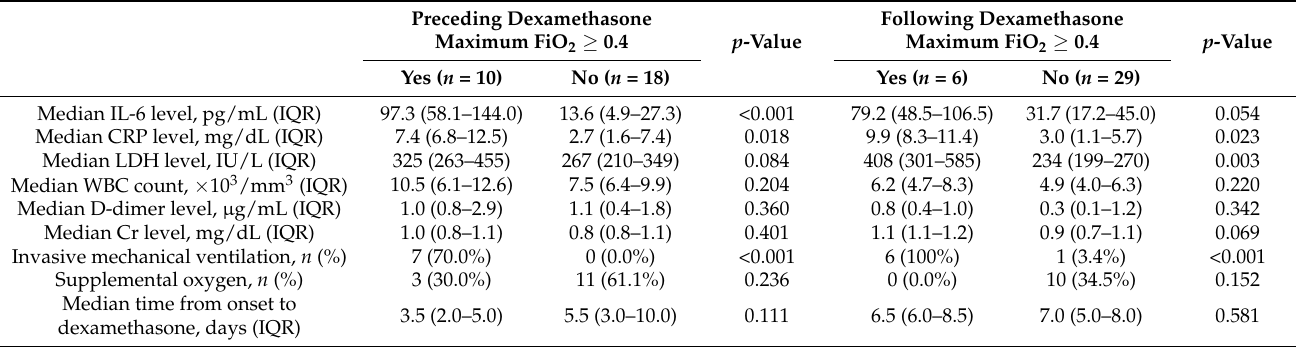
Table 2. Clinical characteristics between the two groups in the patients who received dexamethasone before or after measurement of blood markers.